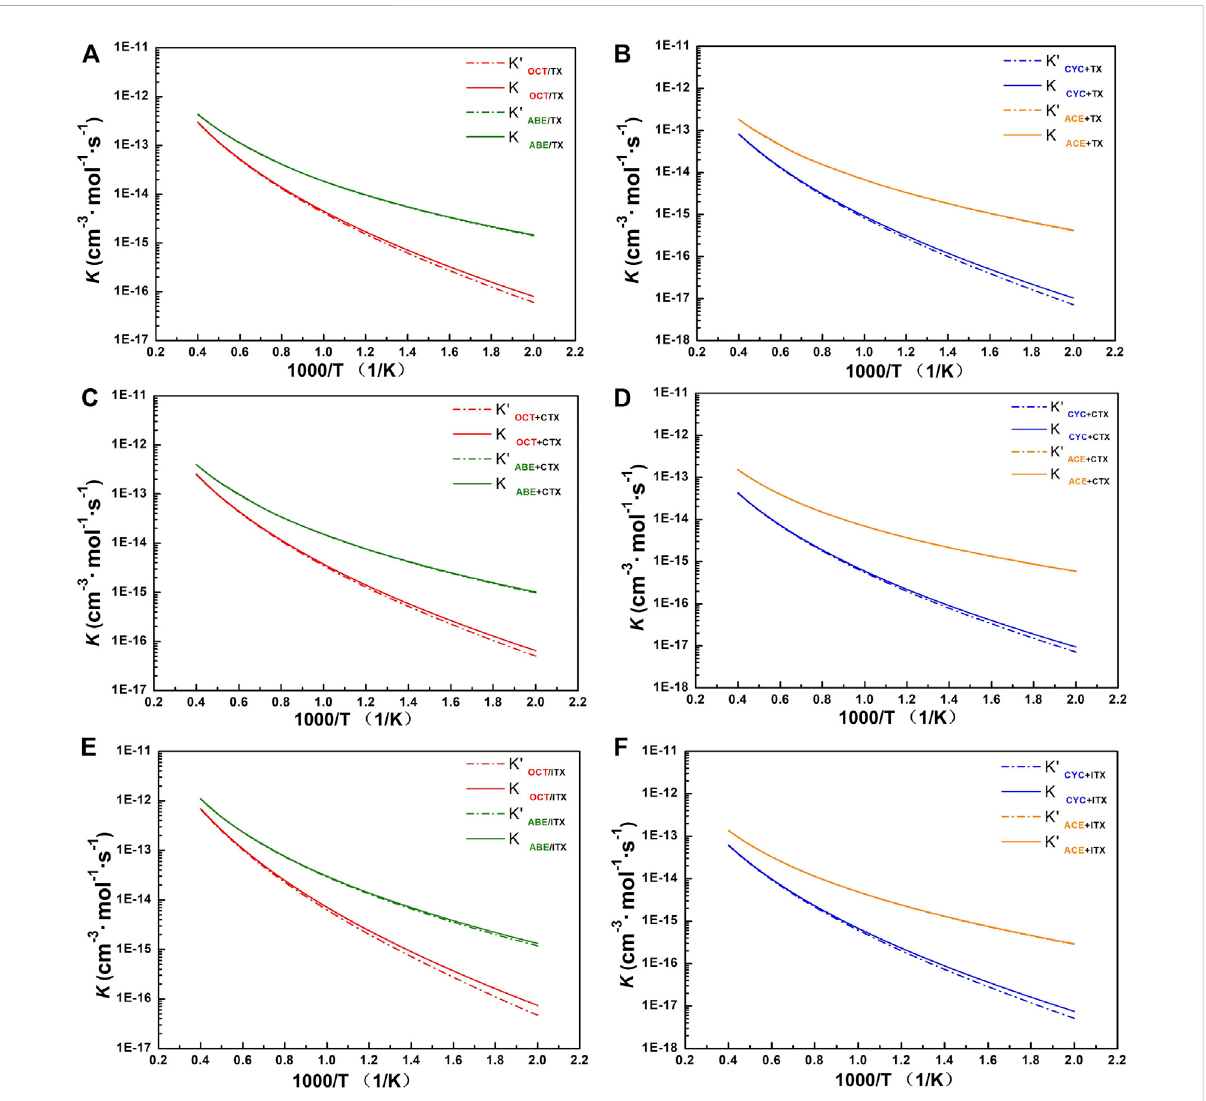
FIGURE 5 The pro fi le of rate constant. (A) TX+OCT/ABE group. (B) TX+CYC/ACE group. (C) CTX+OCT/ABE group. (D) CTX+CYC/ACE group. (E) ITX+OCT/ABE group. (F) ITX+CYC/ACE group. k with and without tunneling correction as a function of temperaturefrom 500 to 2,500 K. Dash line: rate constant without tunneling correction. Solid line: rate constant obtained with Eckart ’ s